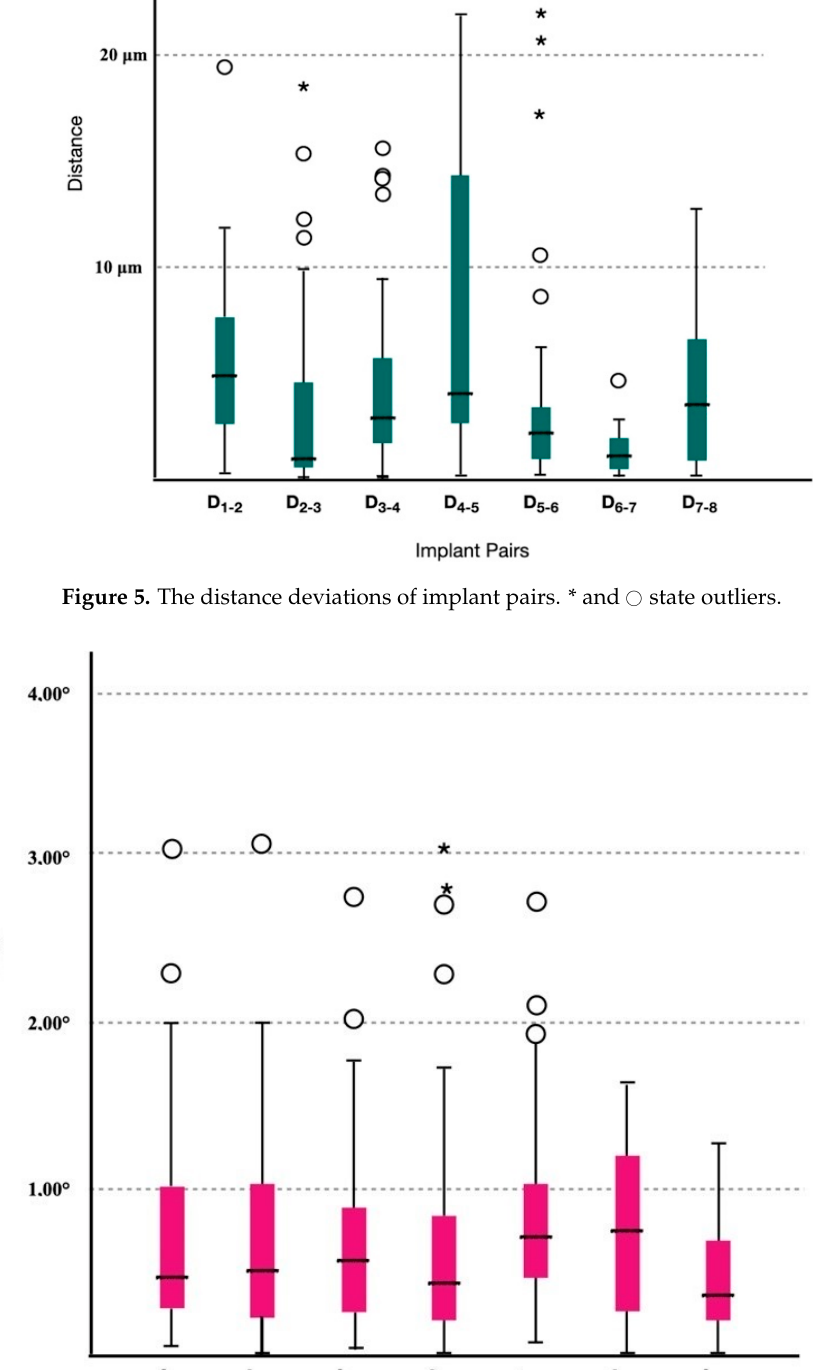
Figure 6. The angular deviations of implant pairs. * and ○ state outliers. In D 6-7 and D 2-3 , where the distance between implants was the lowest, the distance